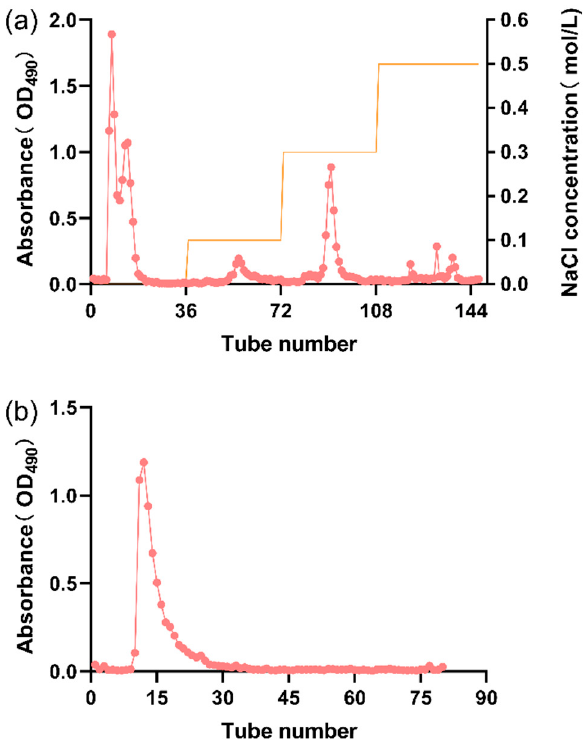
Figure 2. Anion exchange chromatography ( a ) on a DEAE–Sepharose Fast Flow column chromatog- raphy and gel permeation chromatography ( b ) on a Sephadex G-200.